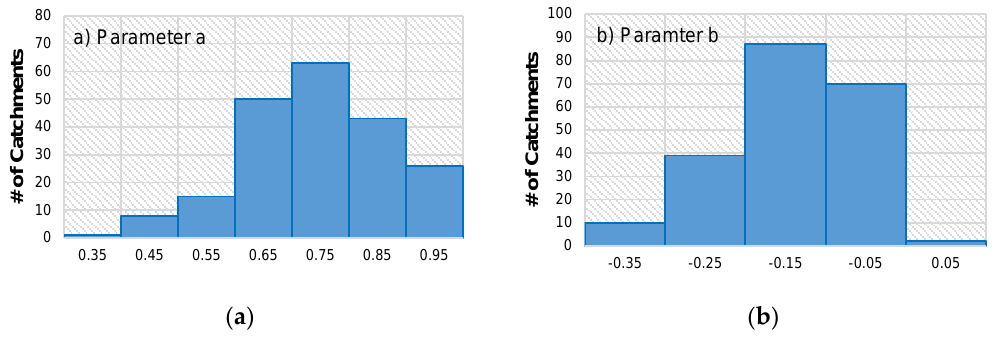
Figure 6. Histograms of parameters ( a ) and ( b ) in the power function.